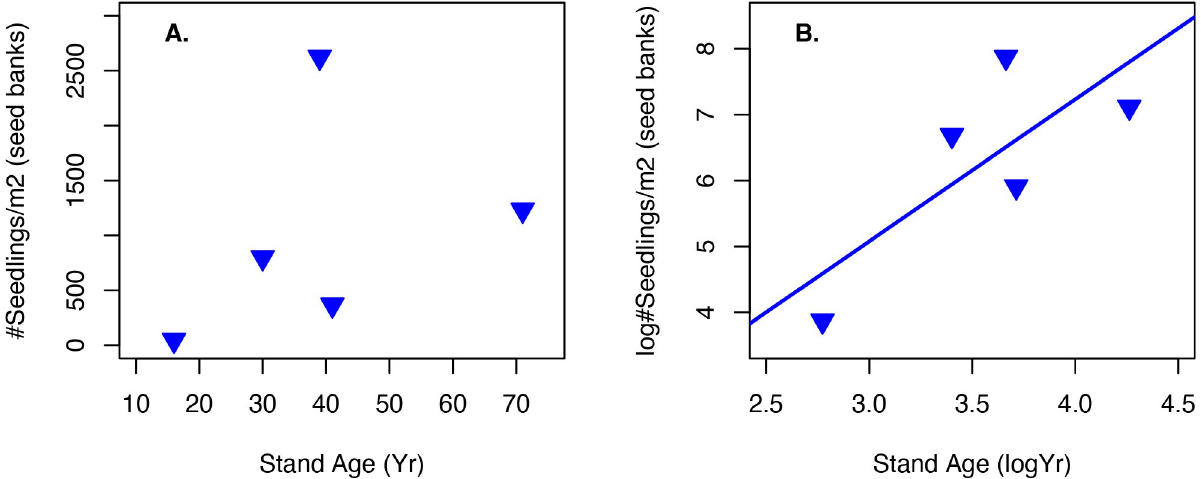
Differential seed predation In the differential seed predation experiment, the largest number of seeds consumed across all treatments during the three-week test period occurred in open trays with 57% of seeds removed (341 of the 600 seeds). Elevated screens and closed (screened) trays had approxi- mately the same amount of total seed predation during the same period (105 and 93 seed lost,